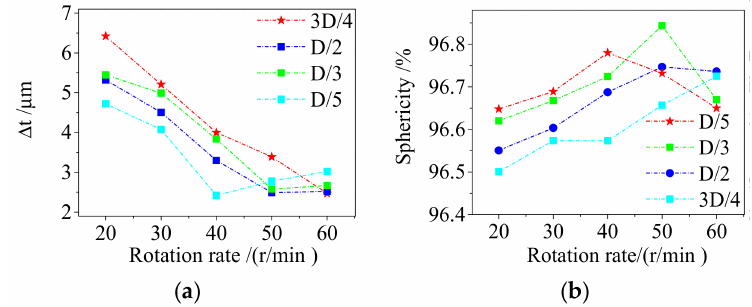
Figure 6. The e ff ects of the rotation rate and liquid level on the quality of the hollow microspheres. ( a ) Uniformity of wall thickness; ( b )